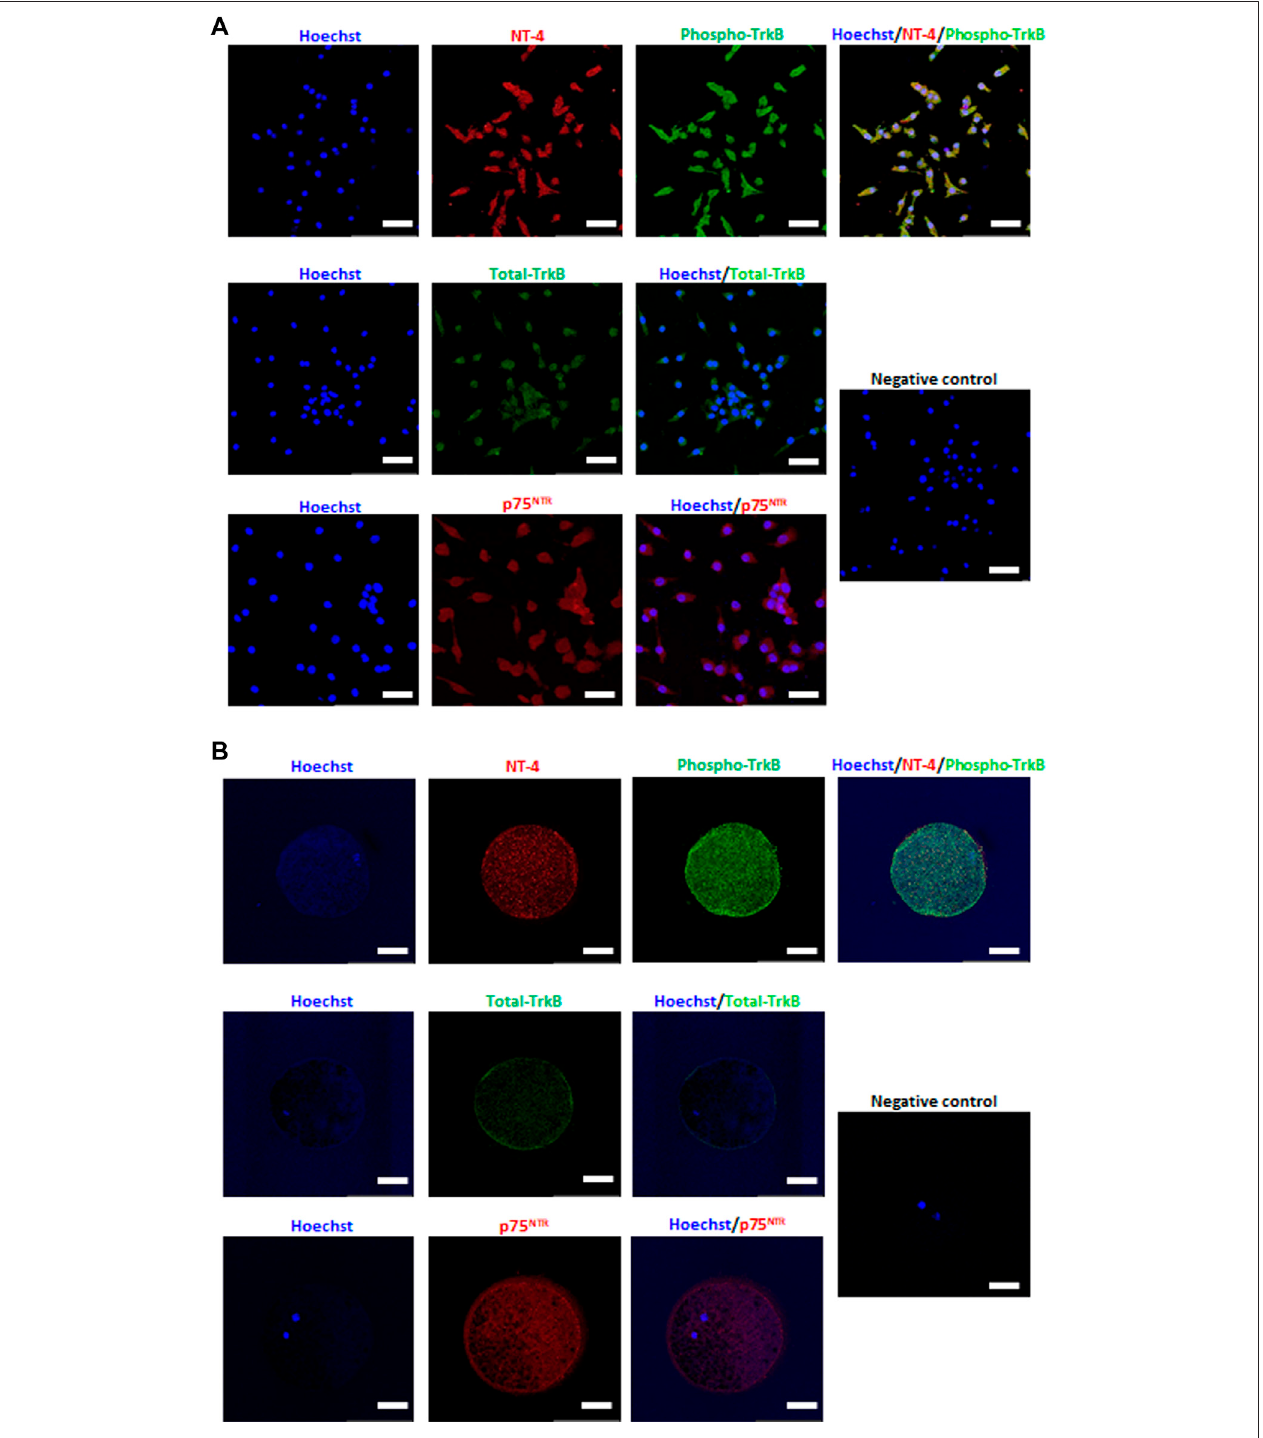
FIGURE 1 | Detection and localization of neurotrophin-4 (NT-4) and its receptors in in vitro matured porcine cumulus cells (CCs) (A) and oocytes (B) by immuno fl uorescence analysis. Scale bars = 100 μ m.